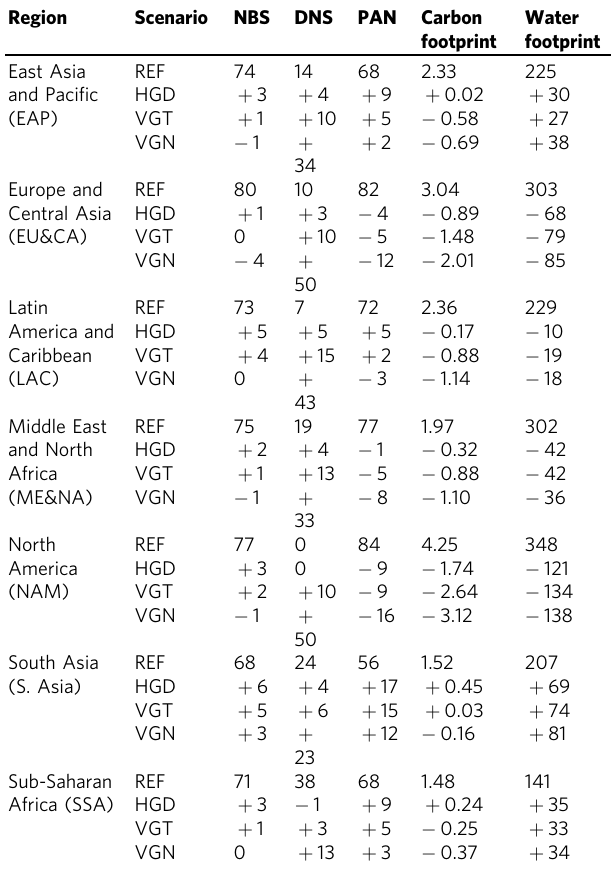
Table 2 Region-speci fi c changes in nutritional indicator values